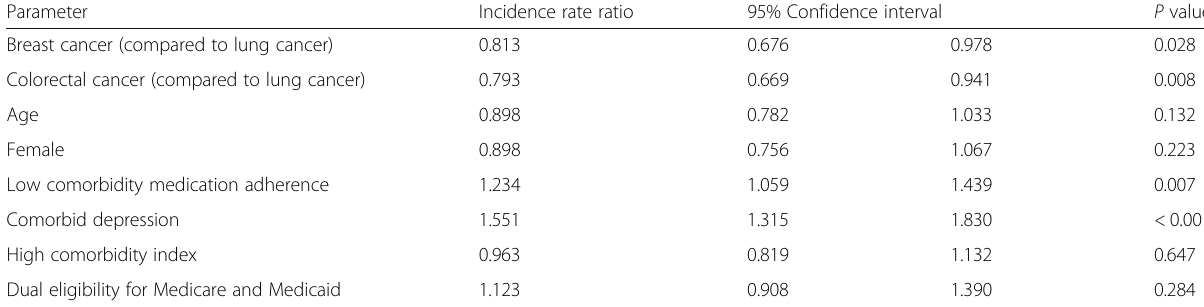
metastatic breast, lung or colorectal cancer Parameter Incidence rate